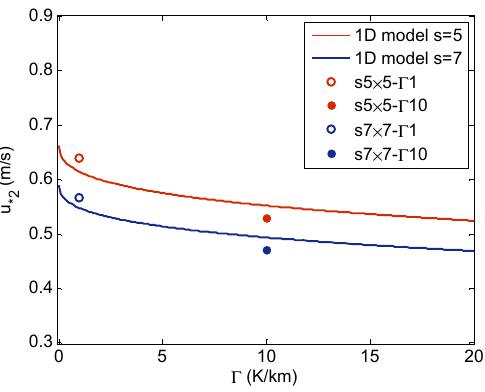
Figure 14. Influence of free-atmosphere stability on the friction velocity at the turbine-top level.